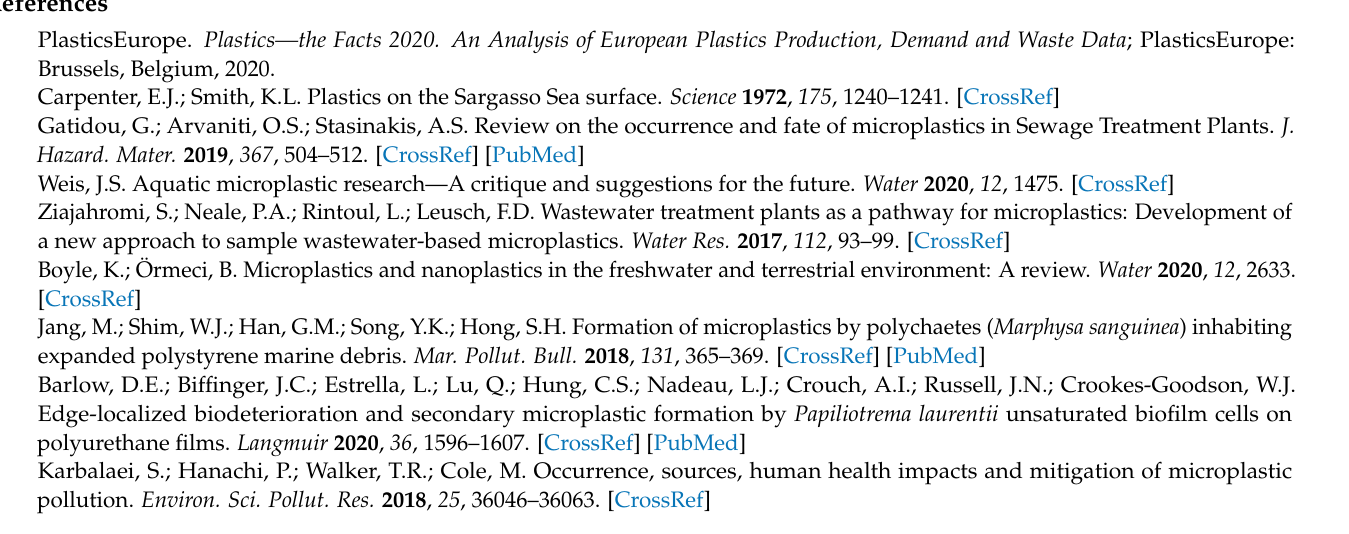
Table S2. Physicochemical and biological parameters. Table S3. Samples and volumes collected in “La Aljorra” WWTP for this study. Figure S1. Location of “La Aljorra” WWTP (37 ◦ 41’16” N, 01 ◦ 03’13”